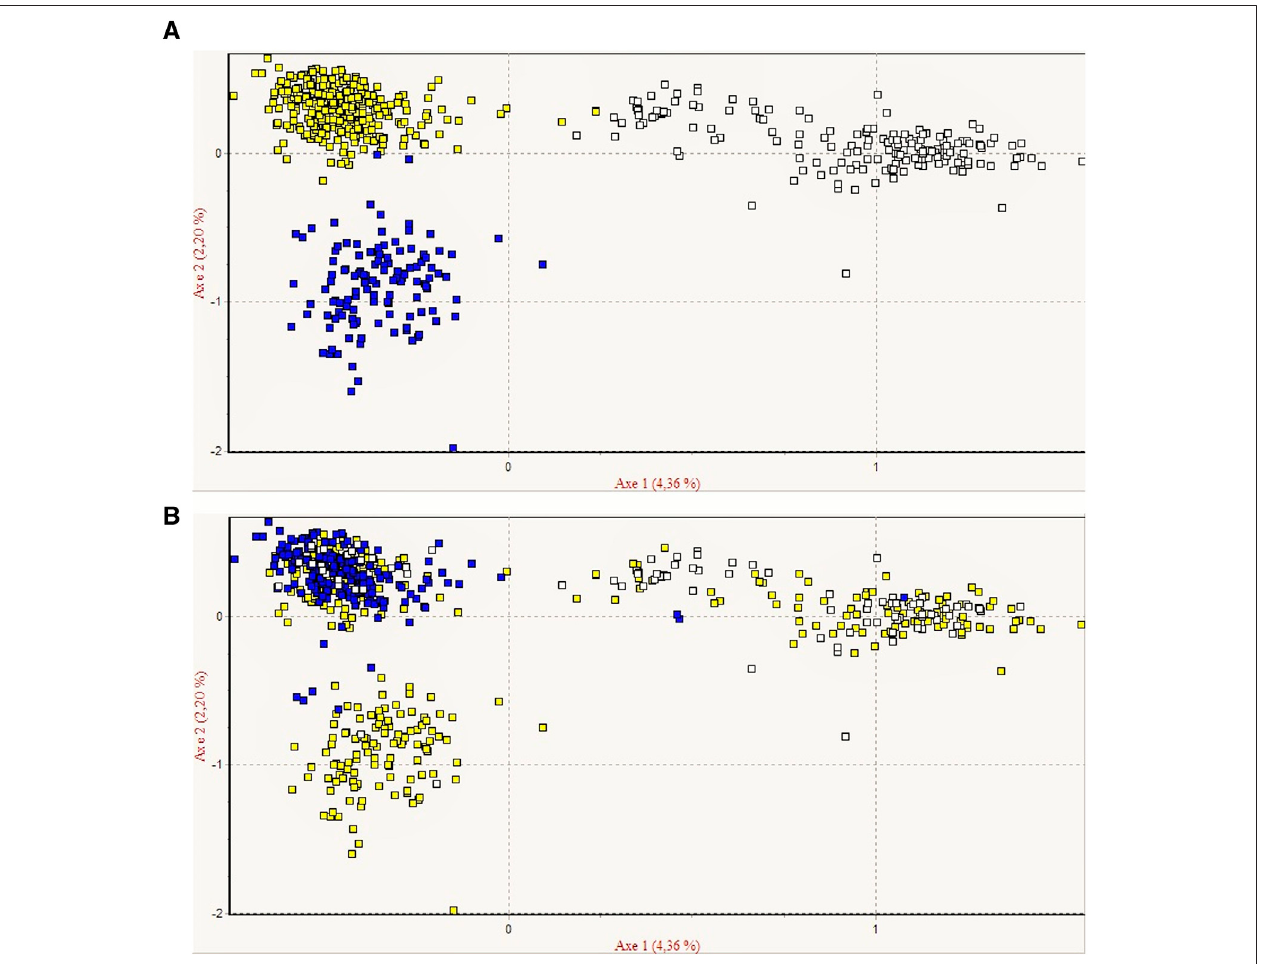
FIGURE 3 | Graphical representation of the factor analysis of correspondence of Curraleiro Pé-Duro cattle (A) . Representation by clusters of genetic similarity (cluster 1 in yellow, cluster 2 in blue, and cluster 3 in white) (B) . Representation by state (Goiás in yellow, Piauí in blue, and Tocantins in white).